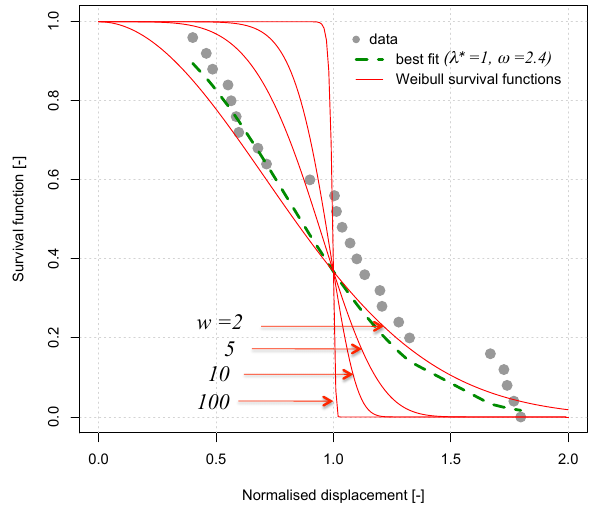
Fig. 4. Survival function for laboratory tensile test data. Gray dots are measurements, the green dashed line shows the best fit using a Weibull exponent ω = 2 . 31 and a normalized scaling factor λ ∗ = 1 . 25. Red lines show the survival functions for ω = 2 , 5 , 10 , 100.